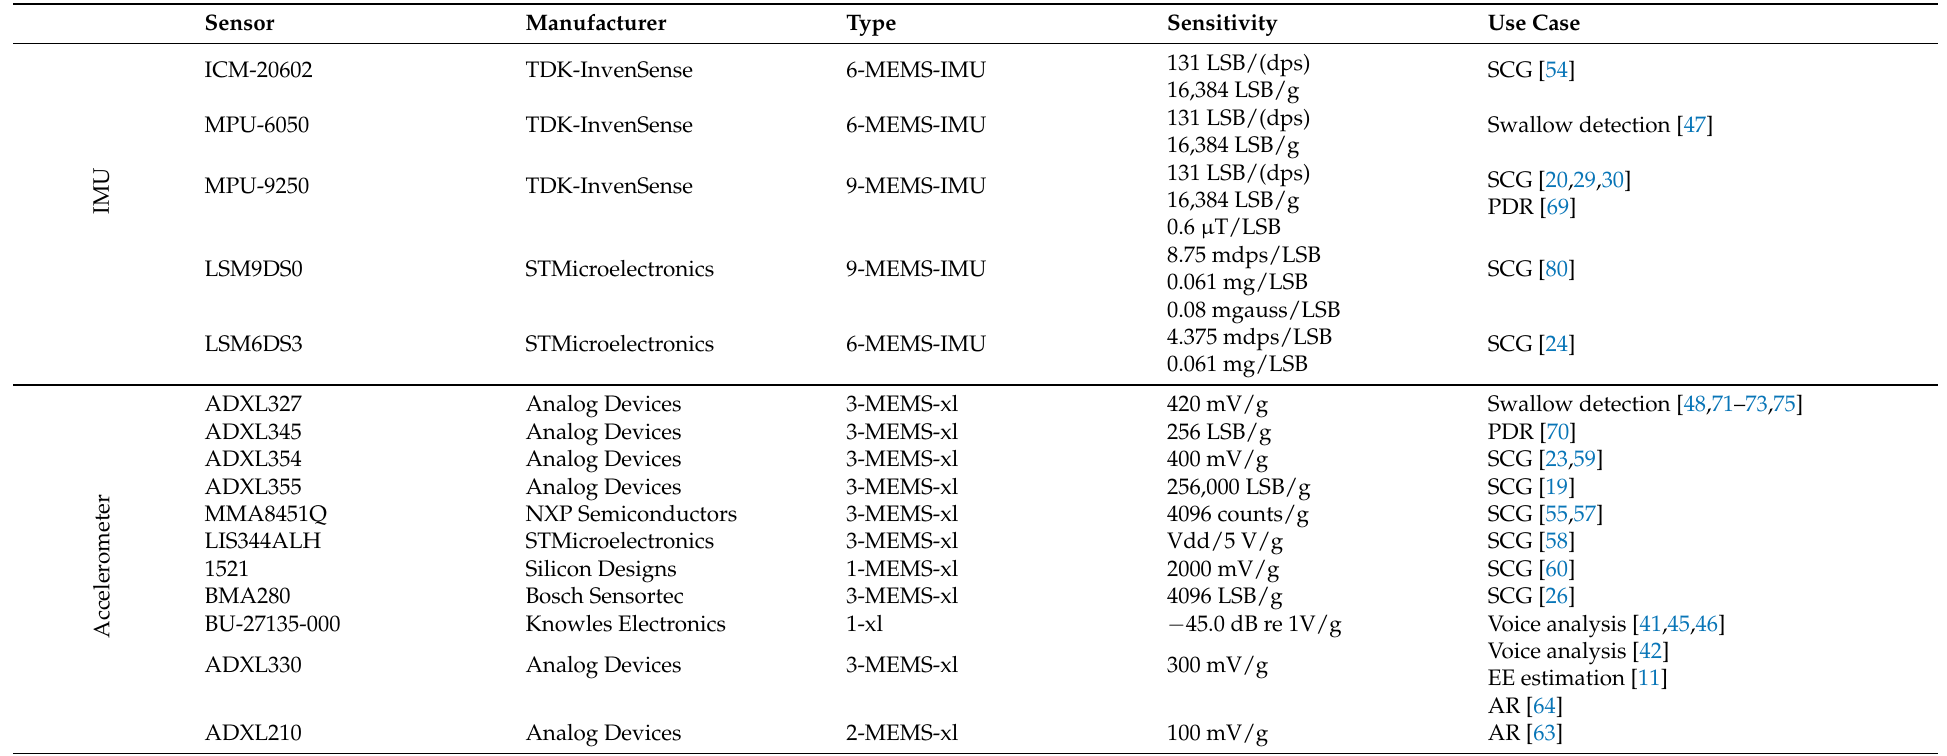
Table 3. Inertial sensors and their sensitivity versus their specific applications in the referenced studies. Preceding numbers in “Type” column reveal degree of